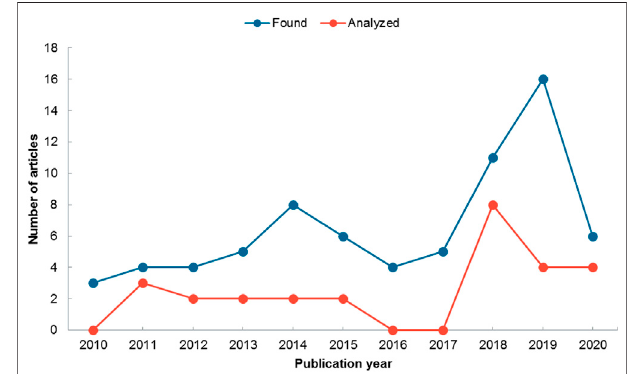
FIGURE 2 | Number of articles published per year on endophytic bacteria and heavy metal tolerance. Blue line shows articles found in the